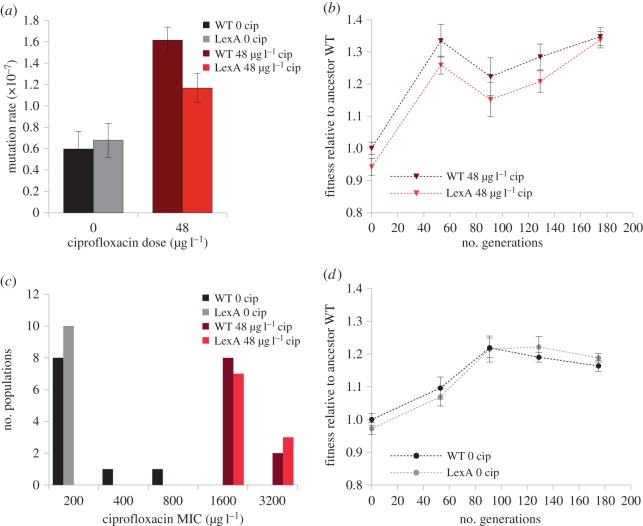
The impact of the SOS response on evolvability. (a) Mutation rate of WT and LexA in the absence or presence of ciprofloxacin, as calculated using a fluctuation test that measures the rate of mutation to rifampicin resistance. Estimation of mutation rate values (and 83% CIs) was done using MSS maximum-likelihood method from eight independent replicates. (b) The fitness trajectory of WT and LexA populations that evolved in the presence of ciprofloxacin. Fitness was measured relative to the ancestral WT strain, and plotted points show the mean and standard error of 10 replication populations for each treatment. (c) The distribution of MIC scores (ciprofloxacin concentration) in WT and LexA populations that were allowed to evolve for 200 generations in the presence and absence of ciprofloxacin. The ancestral WT and LexA clones have an MIC of 200 µg l−1. (d) The fitness trajectory of WT and LexA populations that evolved in the absence of ciprofloxacin. Fitness was measured relative to the ancestral WT strain, and plotted points show the mean and standard error of 10 replication populations for each treatment.